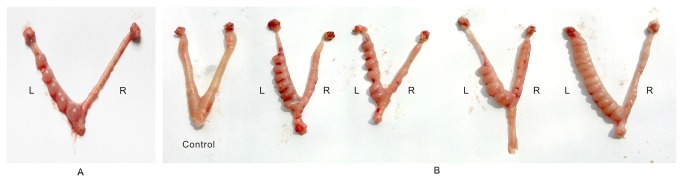
The contraceptive efficacy of PD in Sprague-Dawley rats.(A) A rat uterus with one physiological saline-treated (left) and one PD-treated (right) horn (B) The uterus from an untreated control rat (far left) and several additional Sprague-Dawley rat uteri, each with a physiological saline-treated horn (left) and a PD-treated horn (right).